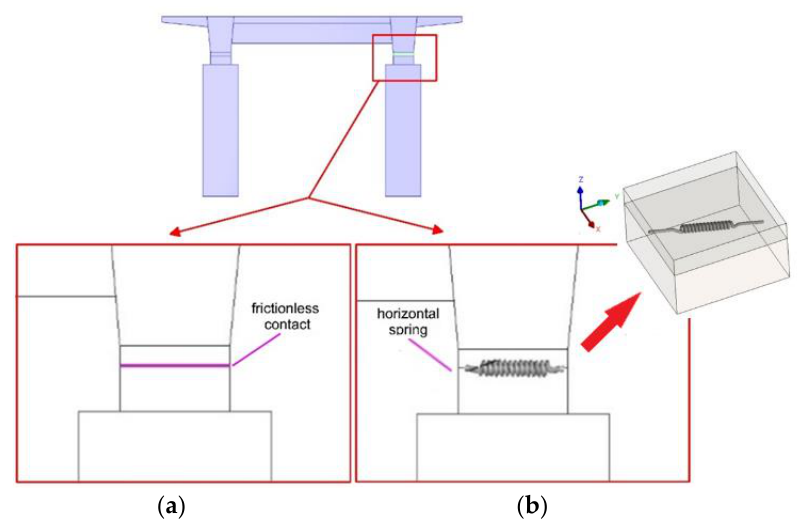
Figure 14. Scheme of the bearing operation in the numerical model ( a ) frictionless contact, ( b ) friction contact modeled by horizontal spring with the detail of the bearing pot in the upgraded numerical model.